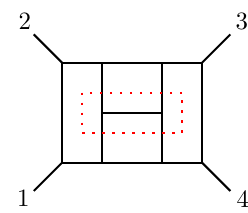
Figure 12 . Our Jacobi identities do not involve doing purely internal BCJ moves at higher